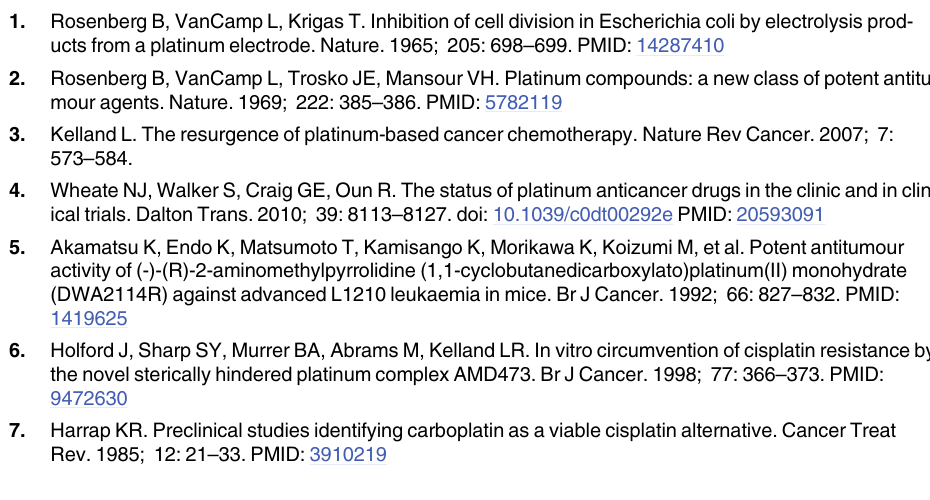
− δ ; ppm) of complex ligand